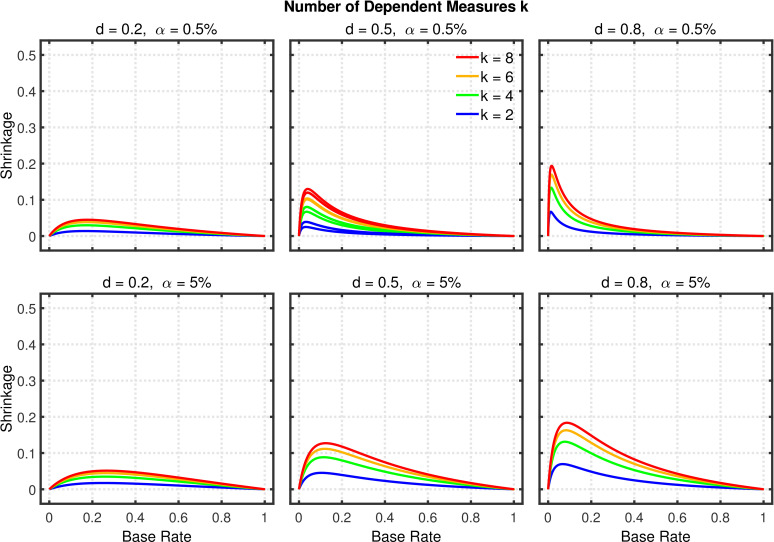
Failing to report all dependent measures.Shrinkage of the replication rate (i.e., the difference between the solid and dashed lines in Figure 8—figure supplement 2) as a function of base rate π, number of dependent measures k, effect size d, and nominal α level (0.5% or 5%).